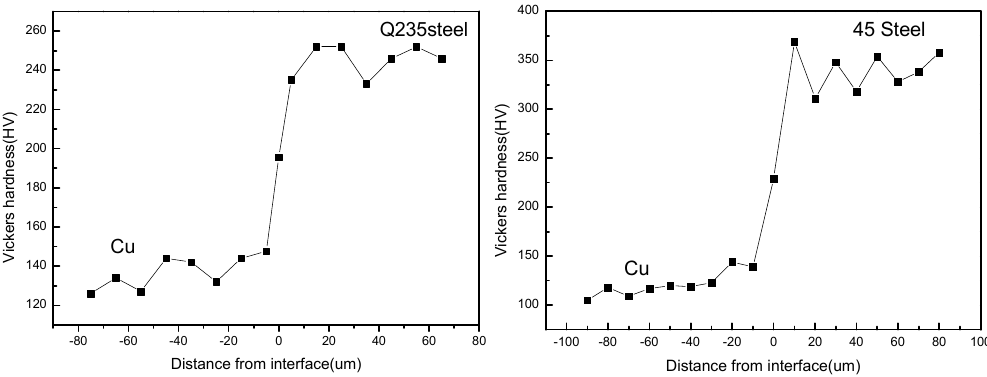
Figure 5c. Coatings 2020 , 10 , x FOR PEER REVIEW